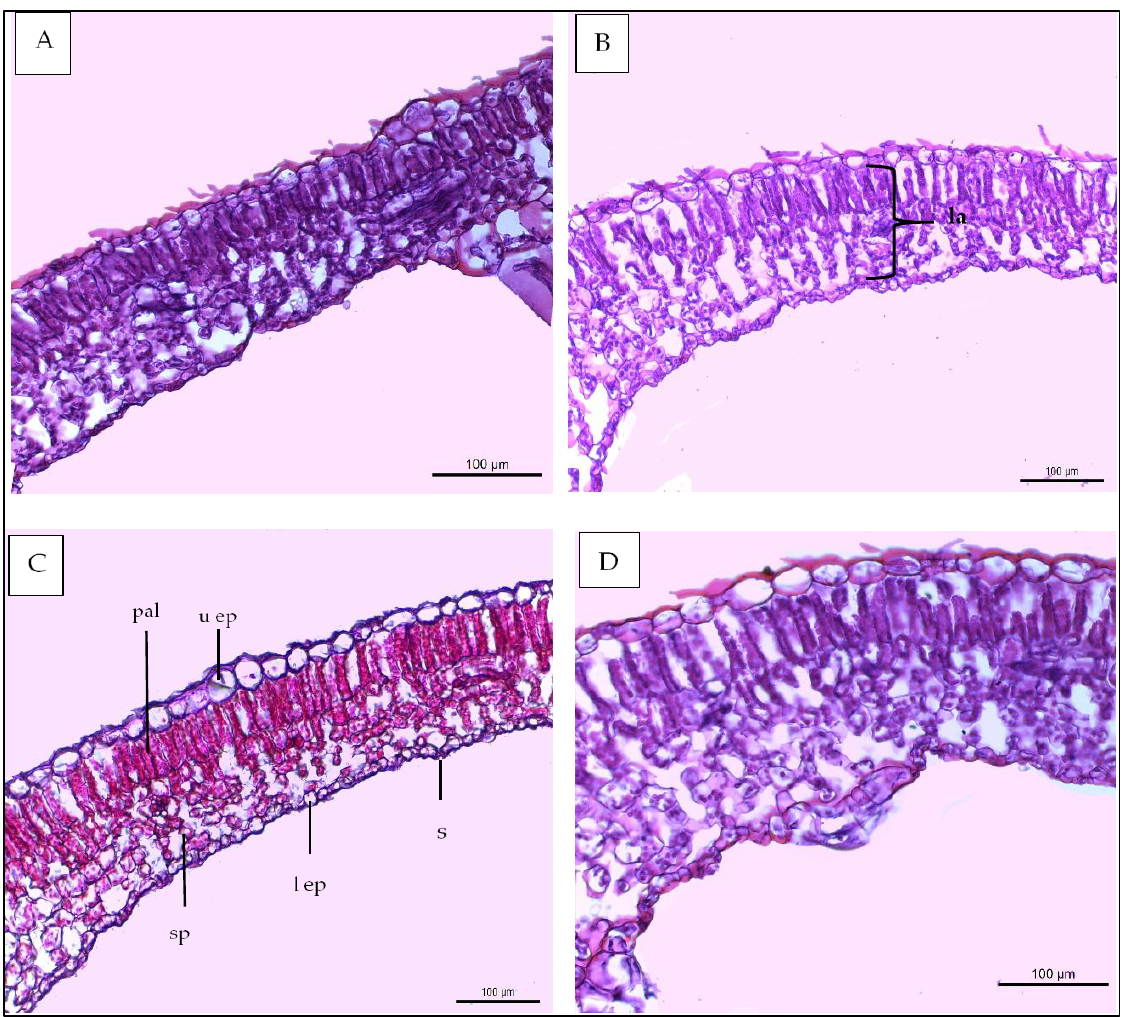
Figure 10. Magnified portions of the leaf blade lamina of summer squash (cv. Eskandarani), aged 50 days. Scale bars = 100 µm. ( A ) Plants affected by powdery mildew (control). ( B ) Plants treated by 40 ppm shikimic acid (SA). ( C ) Plants treated by S. rochei + T. Asperullum (SR + TS). ( D ) Plants treated by mix between 40 ppm SA and (SR + TS). Abbreviations: la — lamina; l ep — lower epidermis; spo — spongy tissue; pal — palisade tissue; u ep — upper epidermis; and s — stomata.